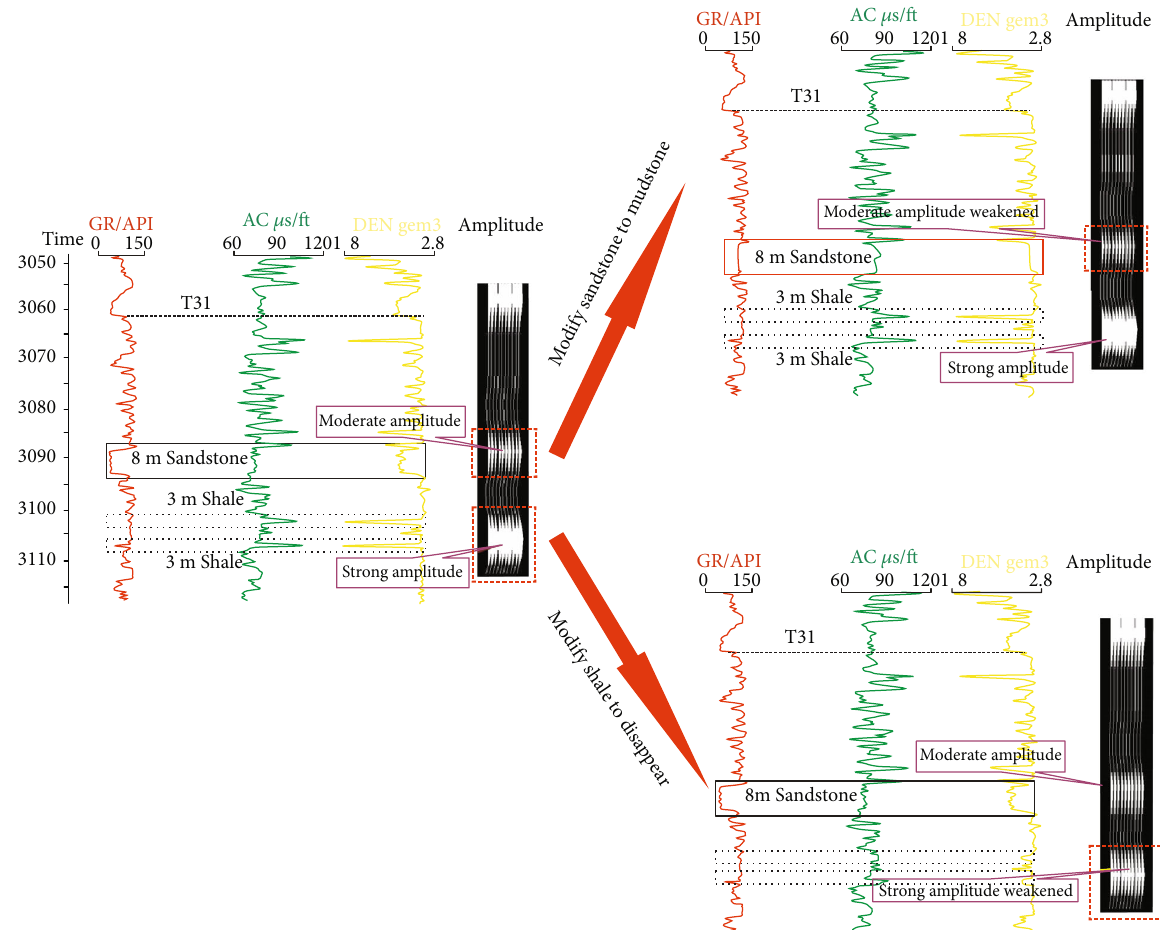
Figure 5: Amplitude corresponding to lithology change: (a) original lithology corresponds to amplitude; (b) lithology, which modi fi es sandstone to mudstone, corresponds to the weaken amplitude; (c) lithology, which modi fi es shale disappeared, corresponds to the weaken